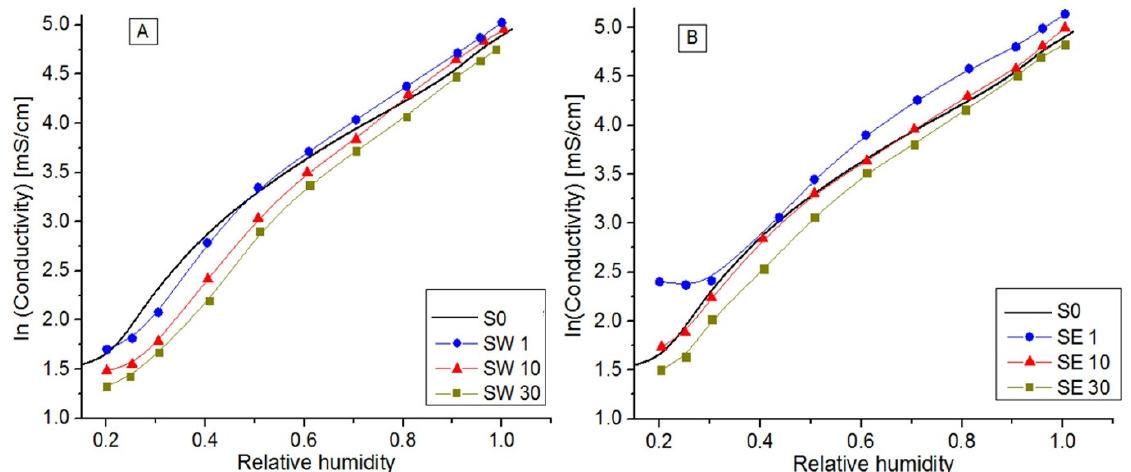
Figure 6. Log plot of the electrical conductivity vs. relative humidity for RF inserted into PFSA using water ( A ) and ethanol–water ( B ) solvents.